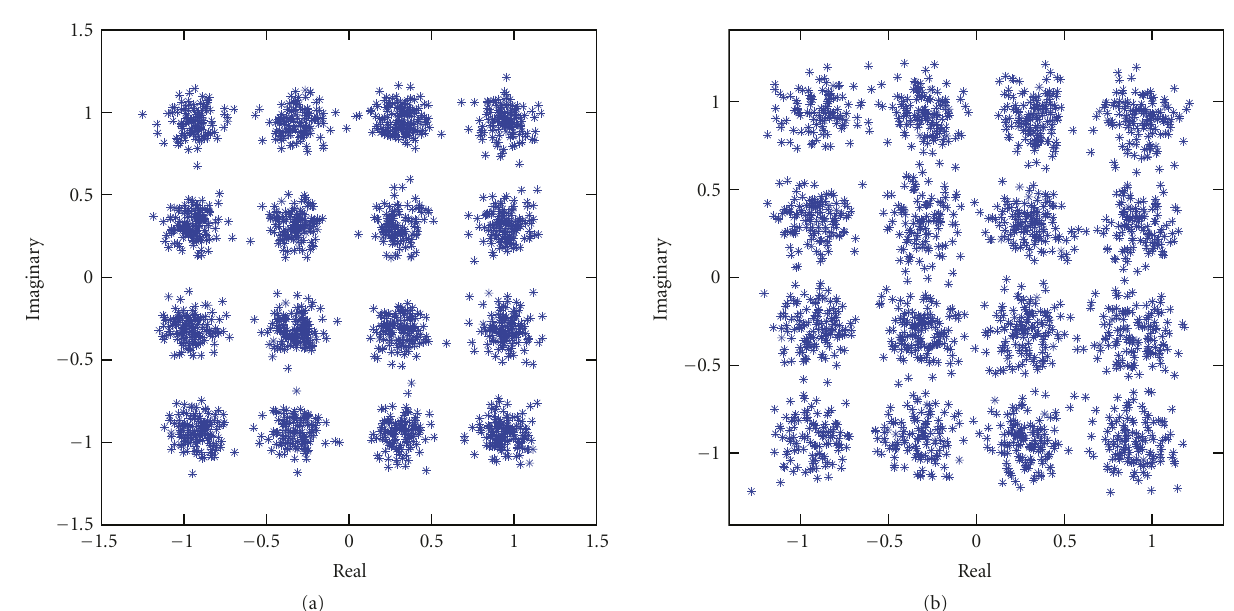
Figure 9: 16-QAM constellations after equalization using (a) GPS or (b)